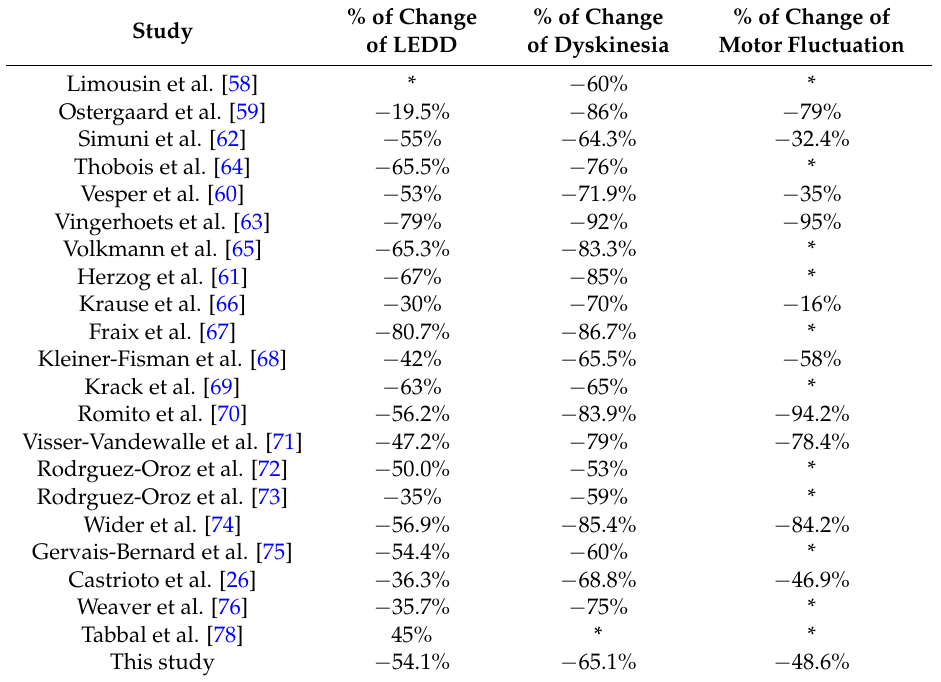
Table 8. Change of LEDD and medication-induced complications in patients in previous studies of bilateral subthalamic nucleus stimulation in